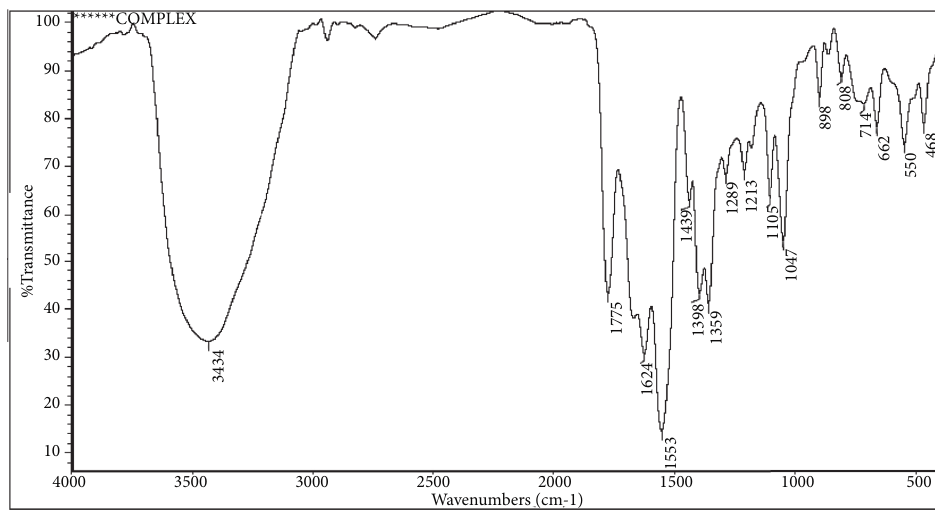
Figure 4: IR spectra of bulk Cu-CFT